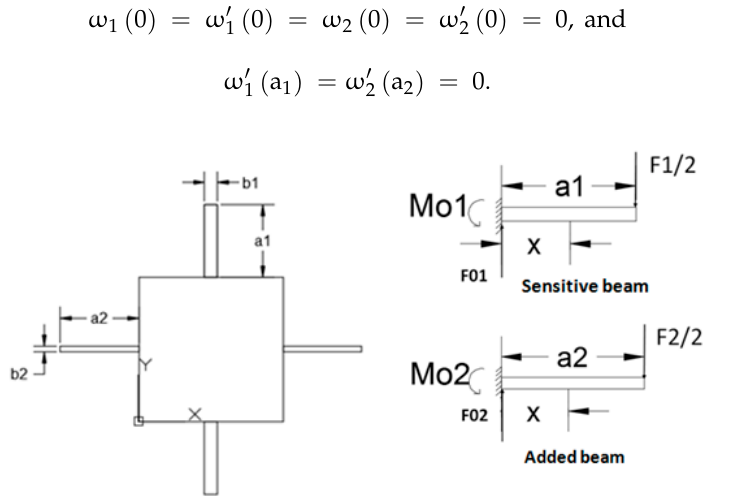
Figure 2. Mechanical analysis of the structure.